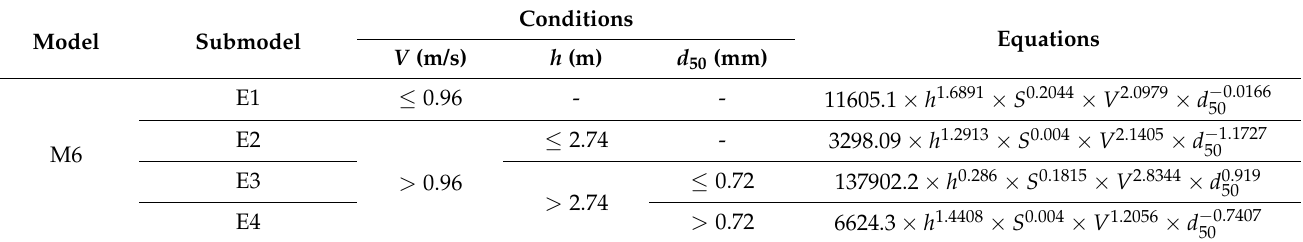
Table 6. Application conditions and determination coefficients of Model 6 (M6).